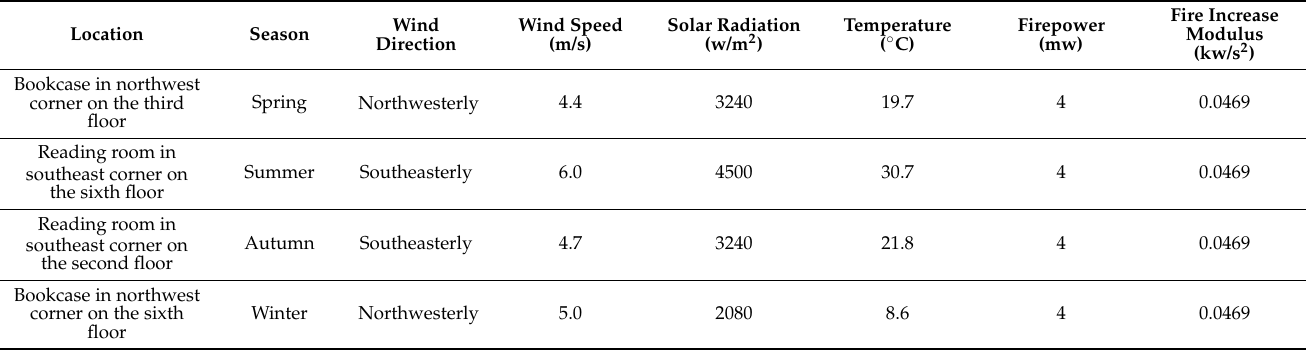
Figure 6. Results for the fire scenario zones across the four seasons in spring ( a ), summer ( b ), autumn ( c ), and winter ( d ). Table 7. Characteristic parameters of the fire scenario zones across the four